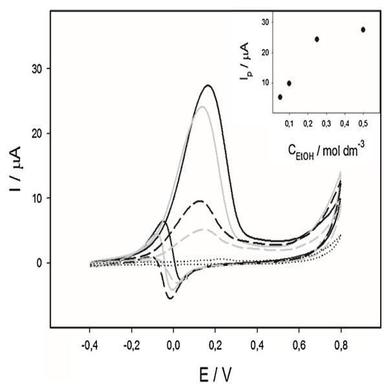
Cycle voltammograms of the electrocatalytical oxidation of ethanol (0.05–0.5 M) in 0.1 M NaOH registered at filtering paper covered with PPy–Au composite. Black dotted line – background without ethanol, grey dashed line – 0.05 M ethanol, black dashed line – 0.1 M ethanol, grey solid line – 0.25 M ethanol, black solid line – 0.5 M ethanol. Scan rate: 20 mV/s. Temp. 20 °C.